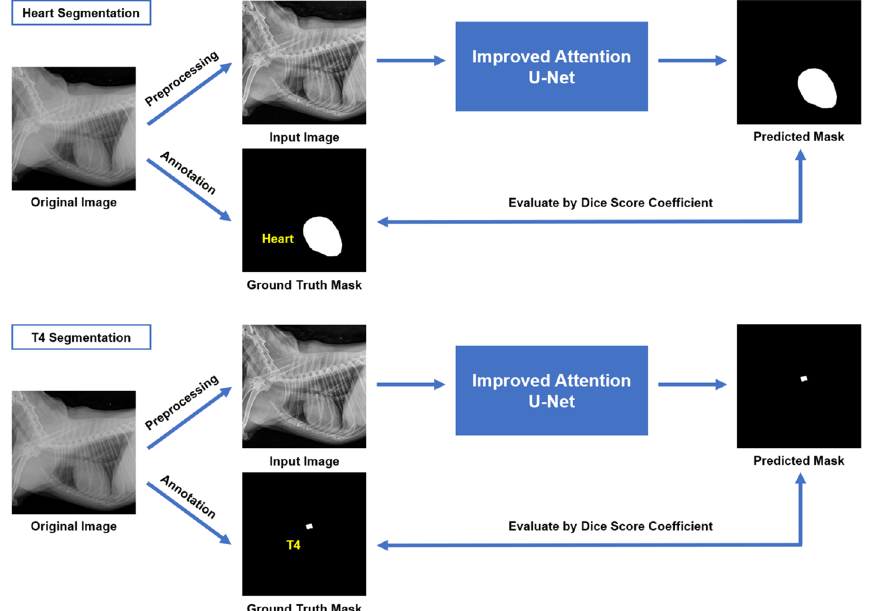
Figure 2. Schematic representation of improved attention U-Net used in semantic segmentation of heart and T4 on canine thoracic radiography. The improved attention U-Net 11 receives both preprocessed input radiographic images and ground truth mask for the heart (top) and T4 (bottom). Both Networks are trained using Tversky loss. Outputs from the networks are predicted masks of heart and T4. Performance of the network is evaluated by dice score coefficient, recall and, precision between ground truth mask and predicted mask.